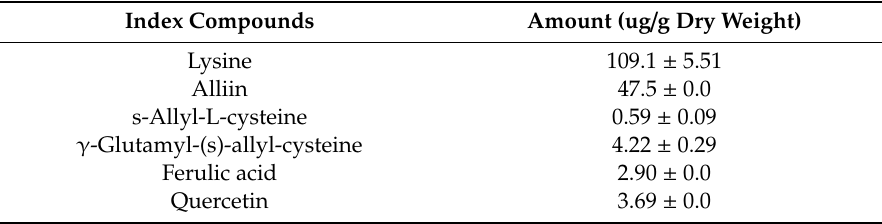
Table 1. Index compounds of rice porridge containing Allium fistulosum root